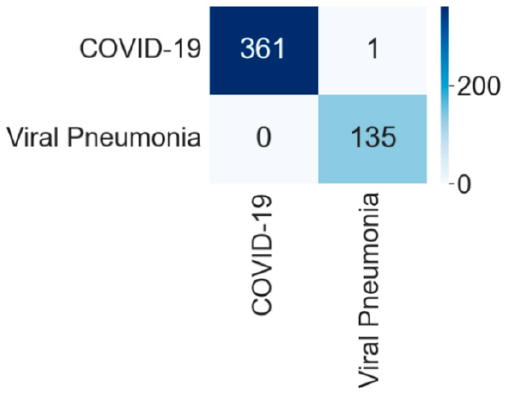
Figure 8. Training and validation loss of best performing NasnetMobile model for COVID-19 and viral pneumonia class.